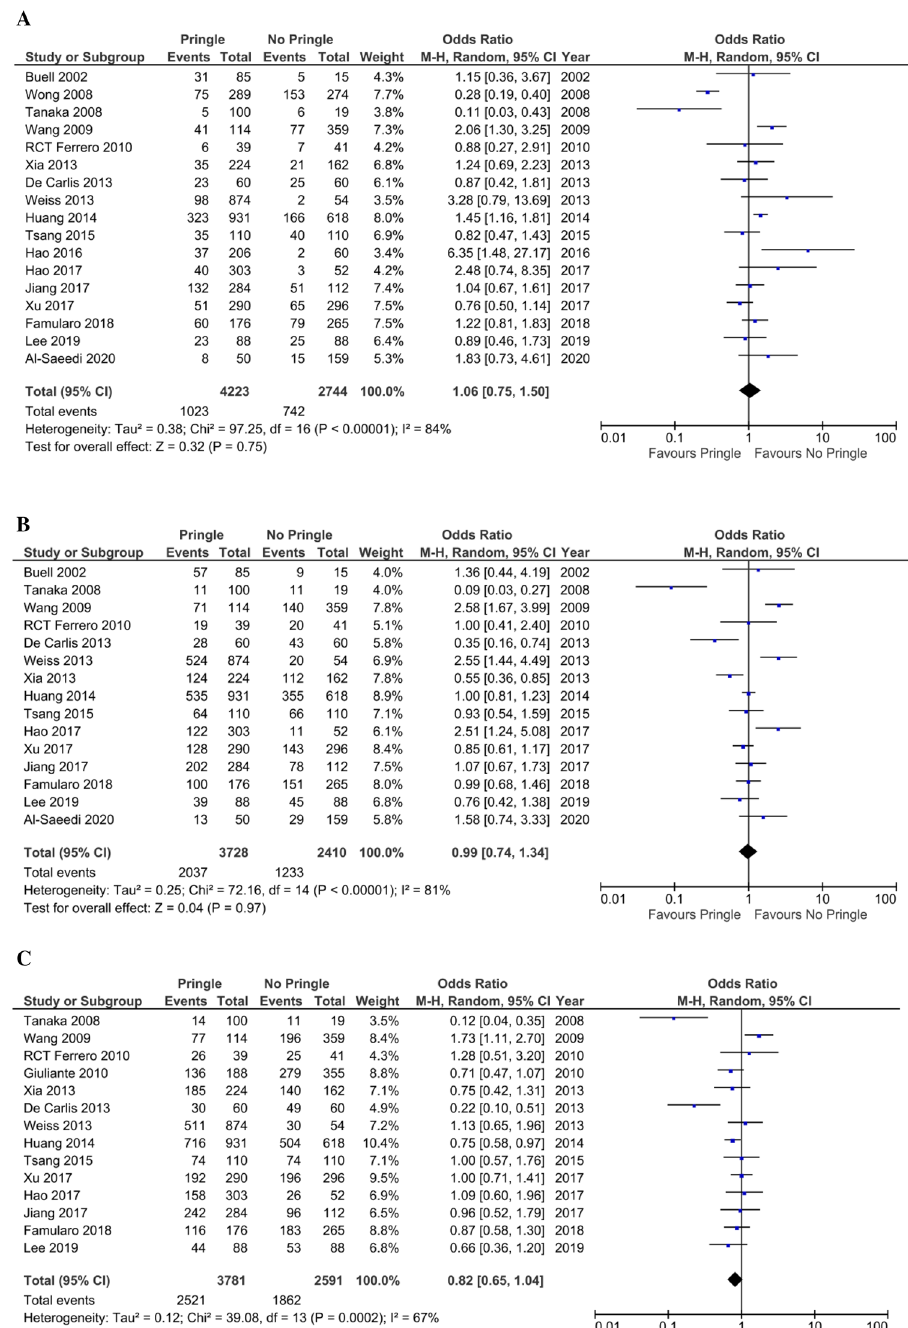
Figure 3. ( A ) Forest plot showing 1-year recurrence of hepatic malignant lesions. ( B ) Forest plot showing 3-year recurrence of hepatic malignant lesions after hepatectomy. ( C ) Forest plot showing 5-year recurrence of hepatic malignant lesions after